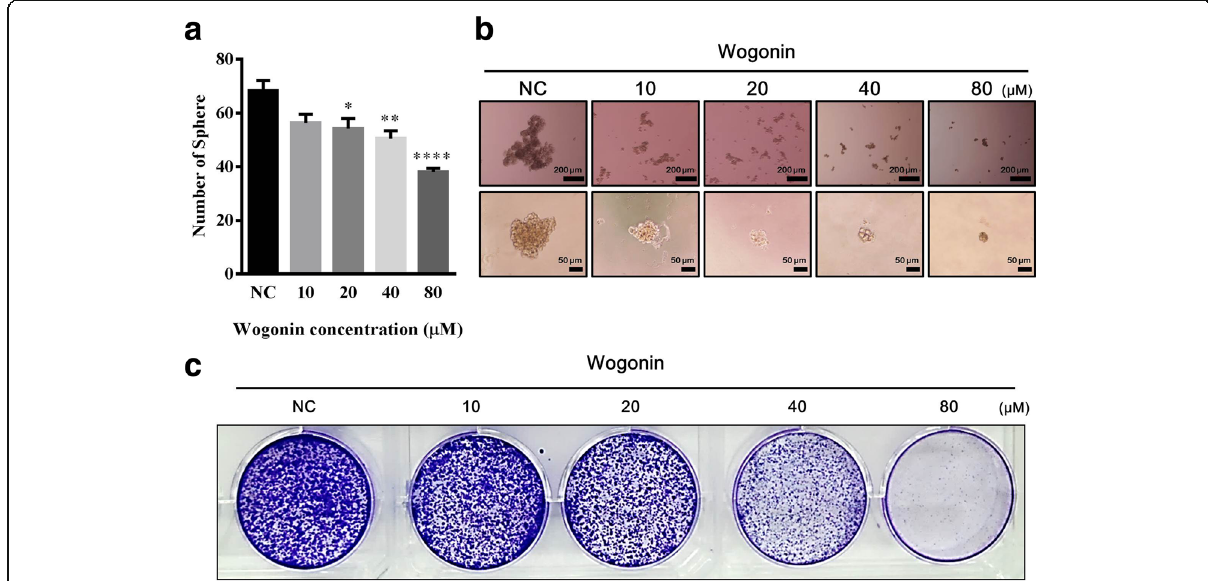
Fig. 4 Effects of Wogonin on the renewal capacity of CD133 + CAL72 CSC. a The effect of Wogonin on inhibiting the number of spheres. b Single sphere formation of CD133 + CAL72 cells after 9 days in suspension culture containing Wogonin (0, 10, 20, 40, and 80 μ M). c Wogonin reduced the clonogenicity of CD133 + CAL72 cells; each well was seeded with 1 × 10 3 cells and incubated at 37 °C with 5% CO 2 after 24 h of Wogonin treatment. Then, the colonies were visualized by staining with 0.5% crystal violet. Data are represented as mean ± SEM ( n = 3). ∗ P < 0.05, ∗∗ P < 0.01, **** P <